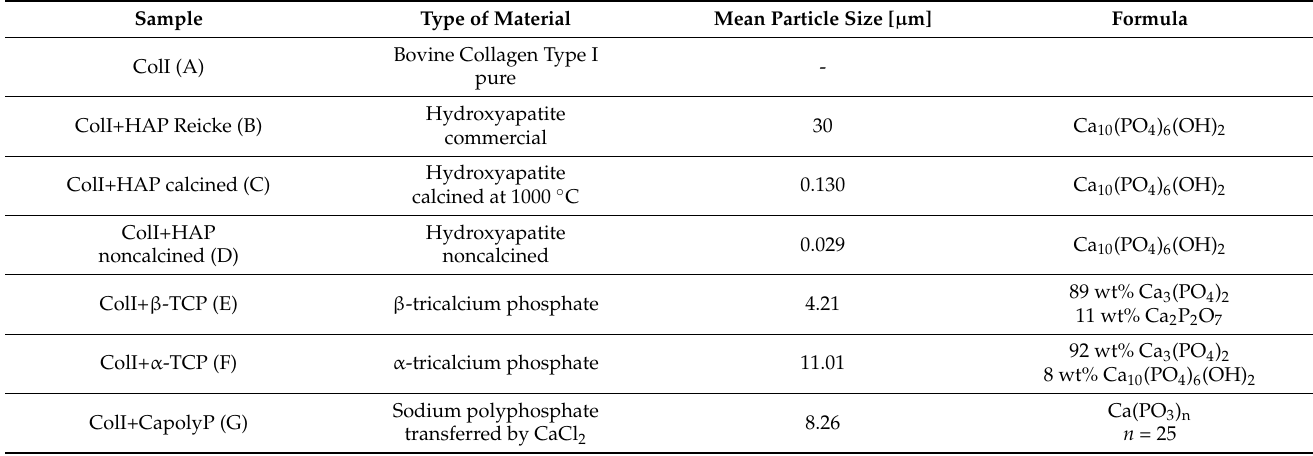
Table 2. The composition of prepared scaffolds; type; mean particle size and